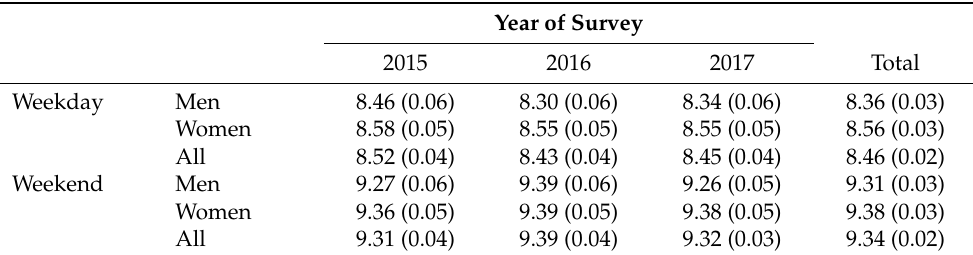
Table 4. Weighted average sleep duration (standard error) on weekdays and at weekends by year and